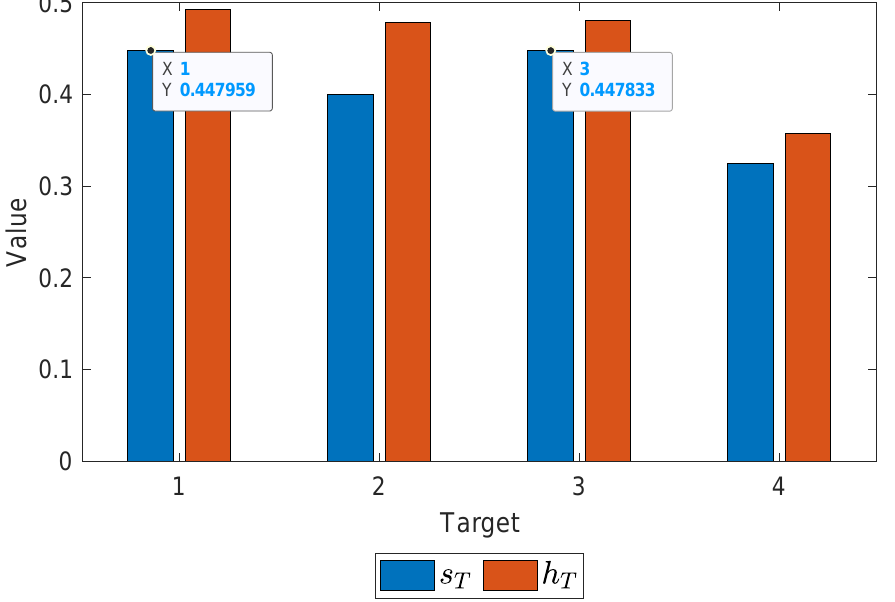
Figure 4. The score values and exact values for the targets under the G-AGSC g